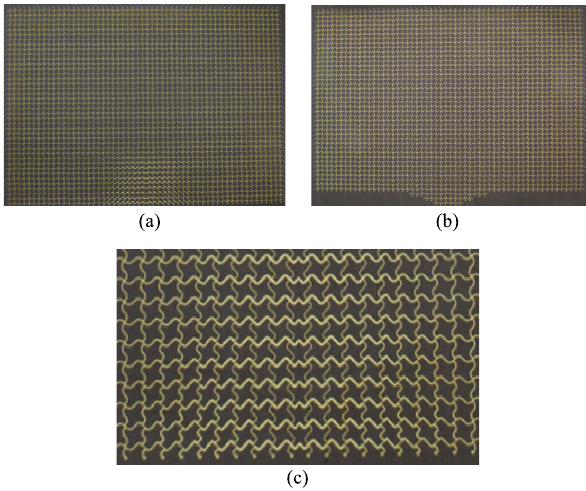
Fig. 18. Prototypes for the measurements. (a) Sample for the groove illusion. (b) Sample with the original groove. (c) Magni fi ed picture of the coordinate transformed area.